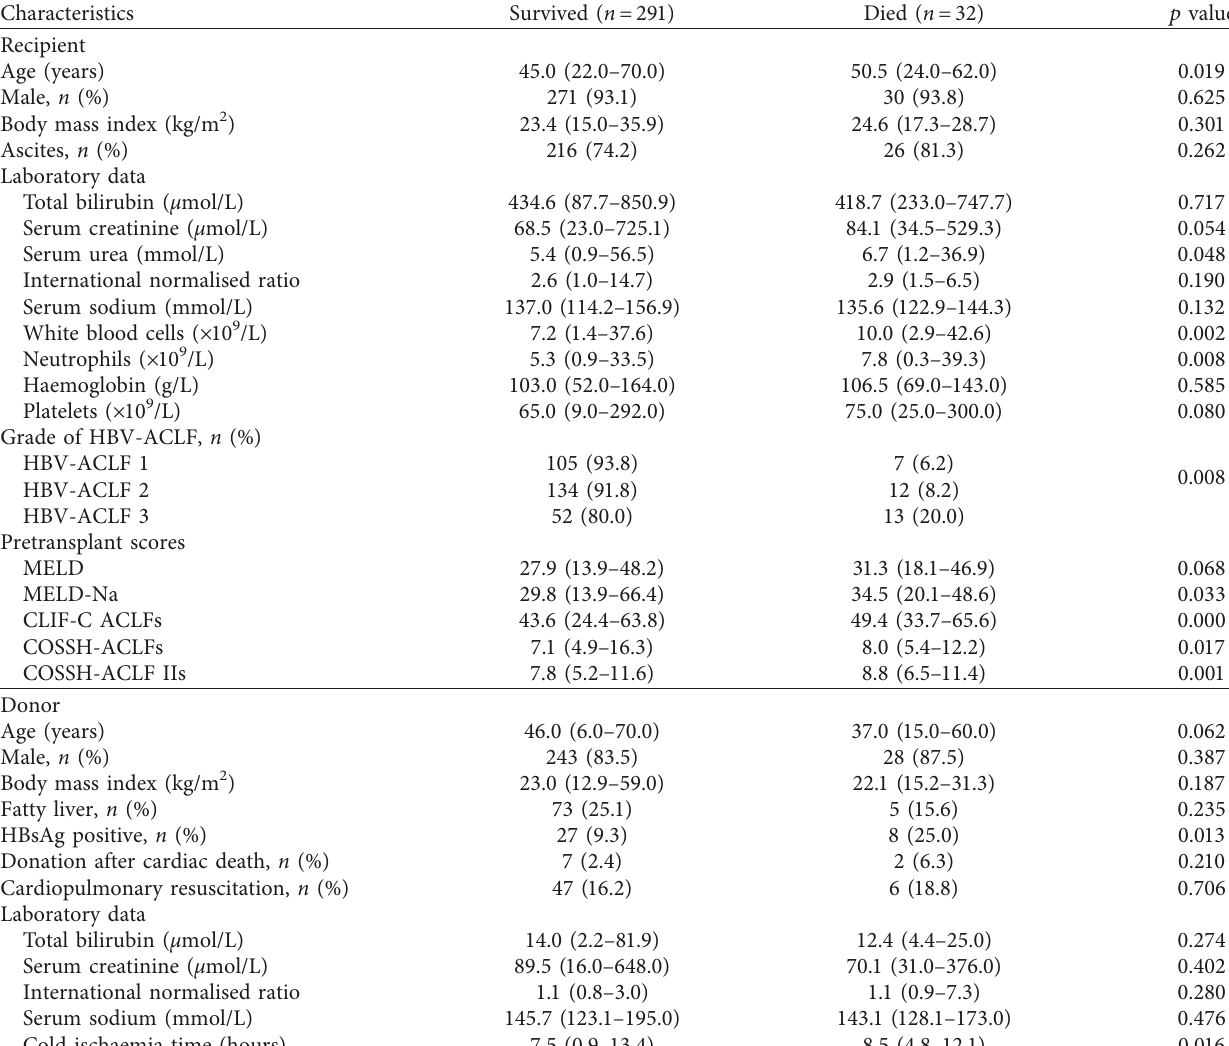
Table 2: Univariate analysis of factors associated with survival after LT in recipients with HBV-ACLF.